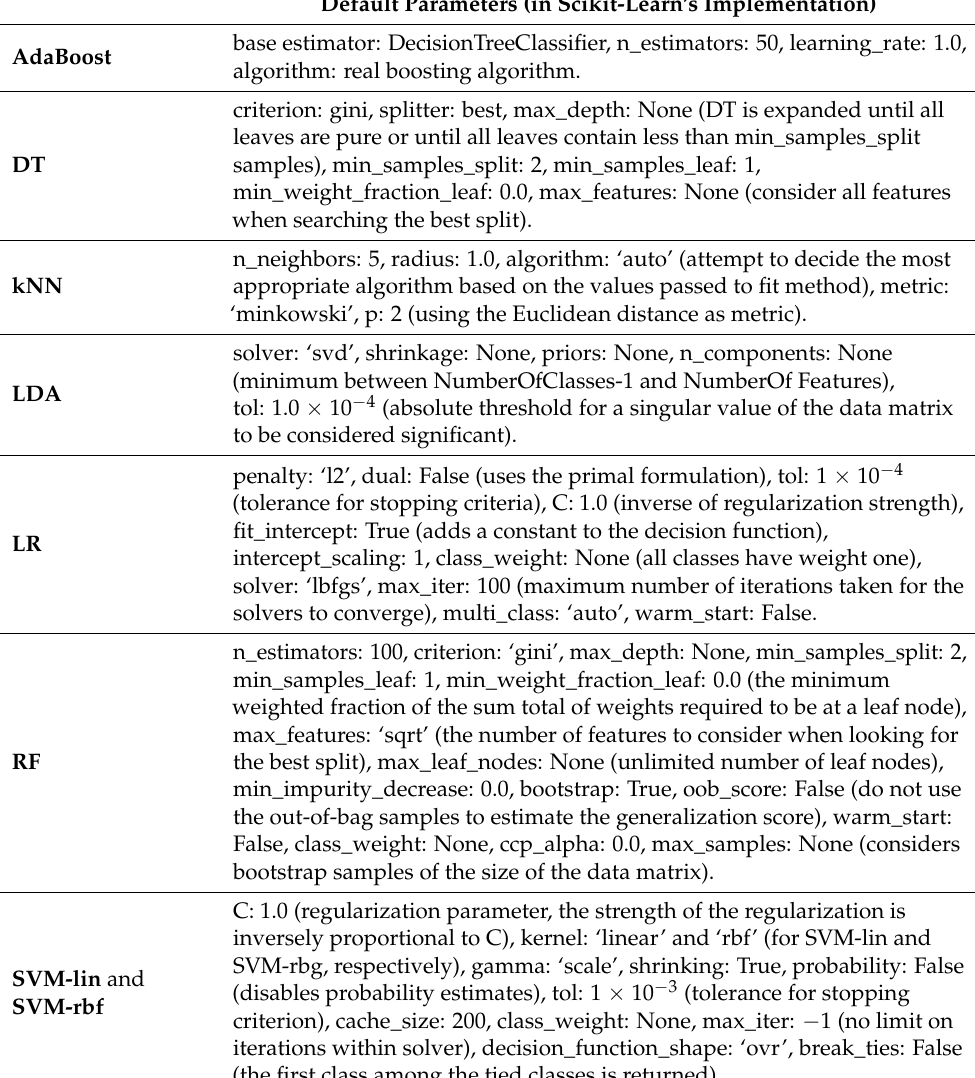
Table 1. Default parameters, in scikit-learn’s implementation, of the machine learning algo- rithms